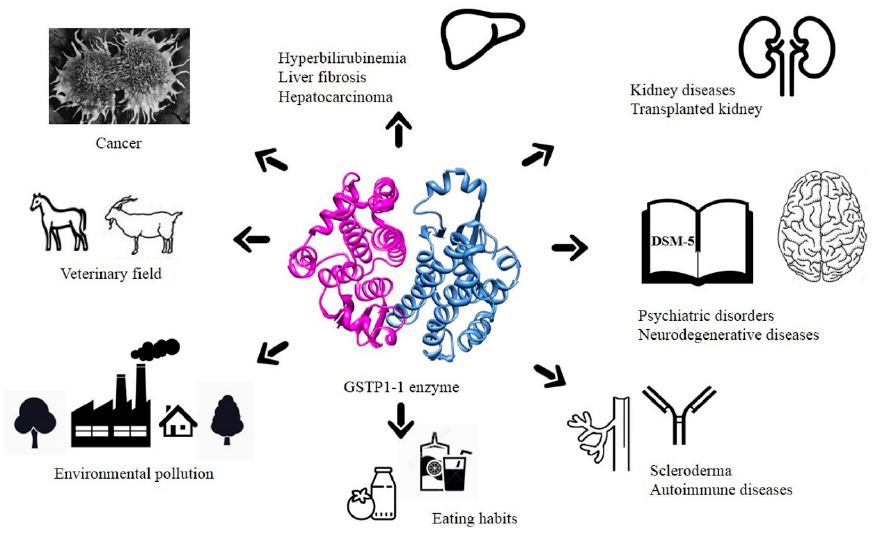
Figure 12. Applications of GSTP1-1 from biomedicine to environmental monitoring.